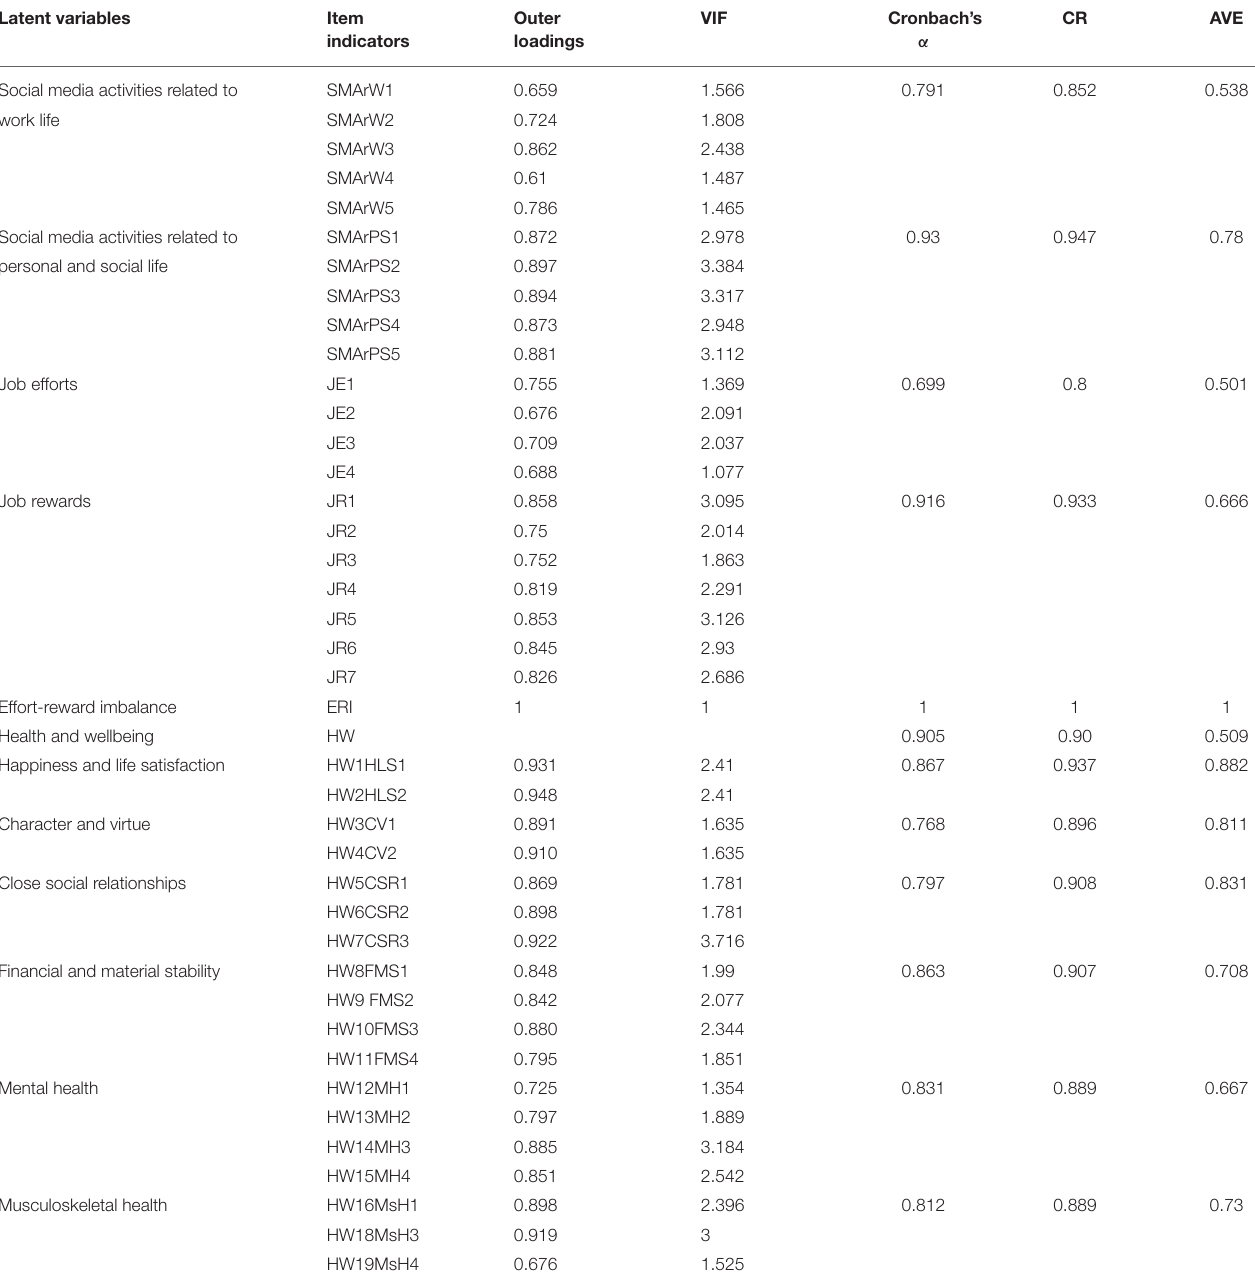
TABLE 5 | Results of reflective measurement